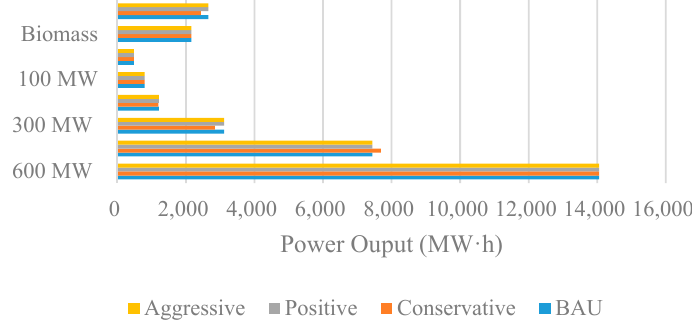
Figure 9. Total power output of units with different carbon scenarios.